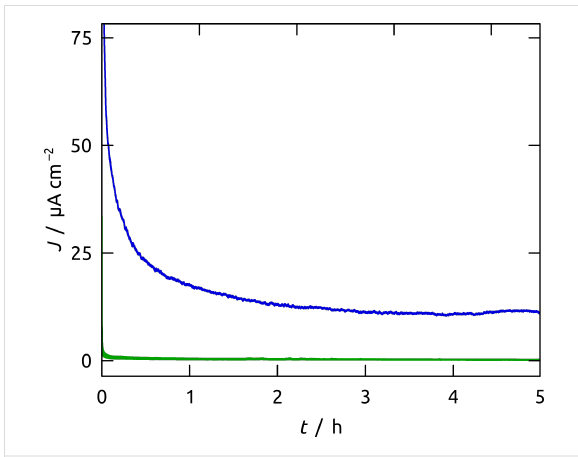
Figure 10: J – t curve of the same nanoporous (blue line) and planar (green line) electrode (as presented in Figure 7) during 5 h of steady- state electrolysis at +0.90 V vs Ag/AgCl.